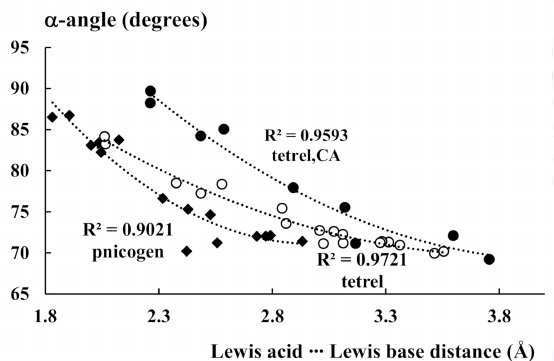
Figure 7. The dependence between the Lewis acid ··· Lewis base distance, Z ··· B, (Å) and the α -parameter (see Scheme 2) in A-Z ··· B tetrel and pnicogen bonds (Z-tetrel or pnicogen centre). Black and white circles correspond to the tetrel complexes linked by charge assisted tetrel bonds and neutral tetrel bonds, respectively. Squares correspond to complexes linked by the pnicogen